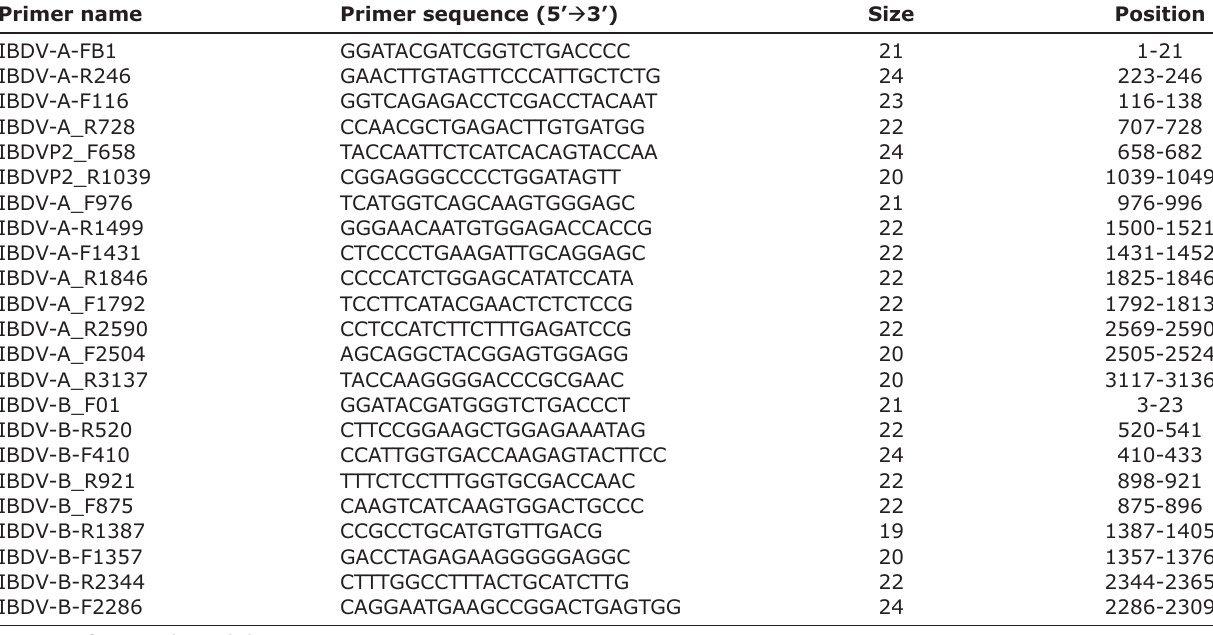
Table-2: Primer designed for whole-genome